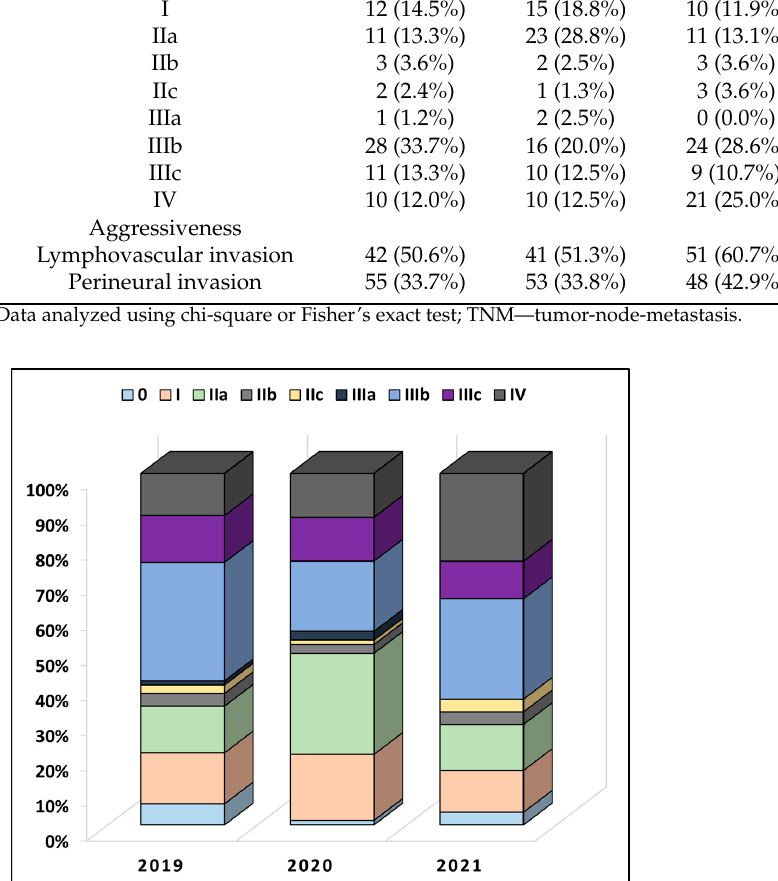
Figure 2. Comparison in TNM staging of colorectal cancer between patients undergoing surgical intervention before (2019) and during the COVID-19 pandemic (2020–2021). intervention before (2019) and during the COVID-19 pandemic